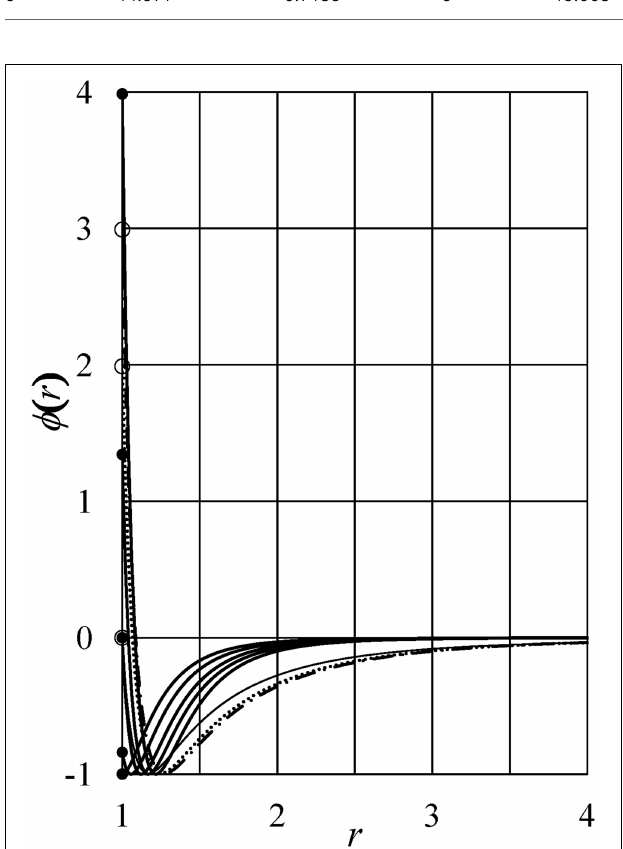
FIGURE 1 | Interaction potentials. Thick full lines: φ 1 ( r ), φ 2 ( r ), ··· , and φ 5 ( r ) from the top to the bottom at r = 1 of the figure, respectively. Thin full line: φ 7 ( r ). Dotted line: φ 8 ( r ). Dot-dash line: φ 9 ( r ). Full and open circles show φ 1 (1 + ), φ 9 (1 + ), φ 8 (1 + ), φ 2 (1 + ), φ 3 (1 + ) = φ 7 (1 + ), φ 4 (1 + ), and φ 5 (1 + ) from the top to the bottom of the figure. Here, 1 + = lim ε → 0 (1 + | ε | ).